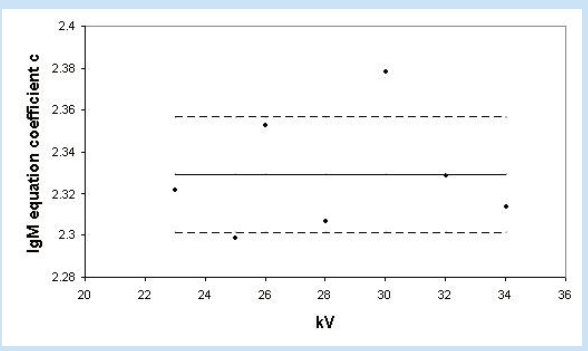
Fig. 5. lgM equation coefficient ‘c’ (Equation 4) as a function of kV. Average